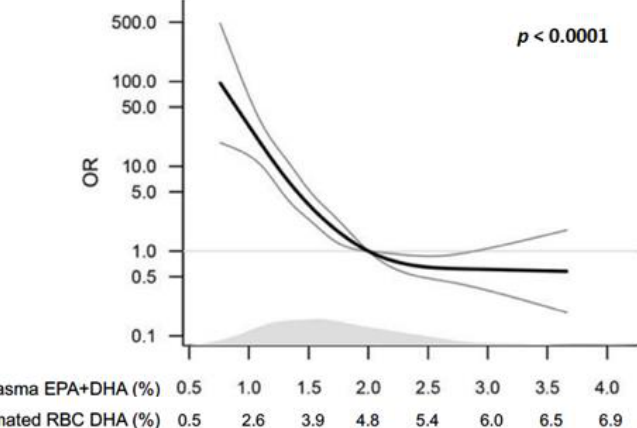
Figure 1. Odds ratios (OR) with 95% confidence intervals (CI) for early preterm birth given measurements of plasma EPA + DHA modelled as restricted cubic splines with five knots. Above the x-axis is shown the density of EPA + DHA measurements estimated in controls. Erythrocyte (RBC) DHA levels were estimated from plasma EPA + DHA (%) with the equation Y = 0.0306 × ln(x) + 0.1673. The equation is based on a sample of 2309 plasma and RBC samples analyzed at OmegaQuant (Sioux Falls, SD, US) in 2017–2018. Figure adapted from Olsen SF et al. 2018 EbioMedicine [6] and used with